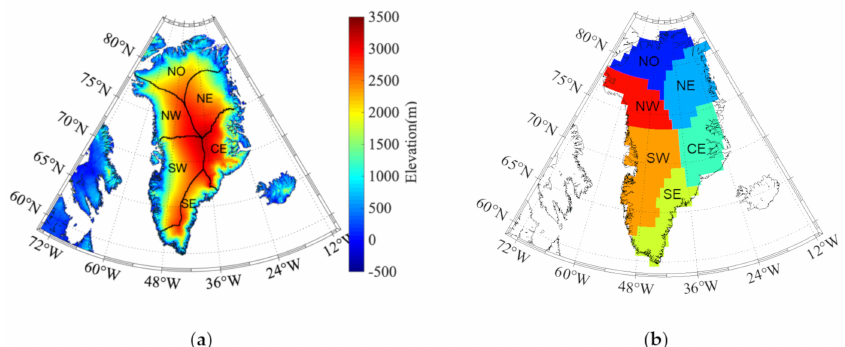
Figure 1. ( a ). The topography of Greenland. The black lines delineate the boundaries of each discharge basin discussed in the text. ( b ). The drainage basins and definitions of the Greenland Ice Sheet (GrIS) for Gravity Recovery and Climate Experiment